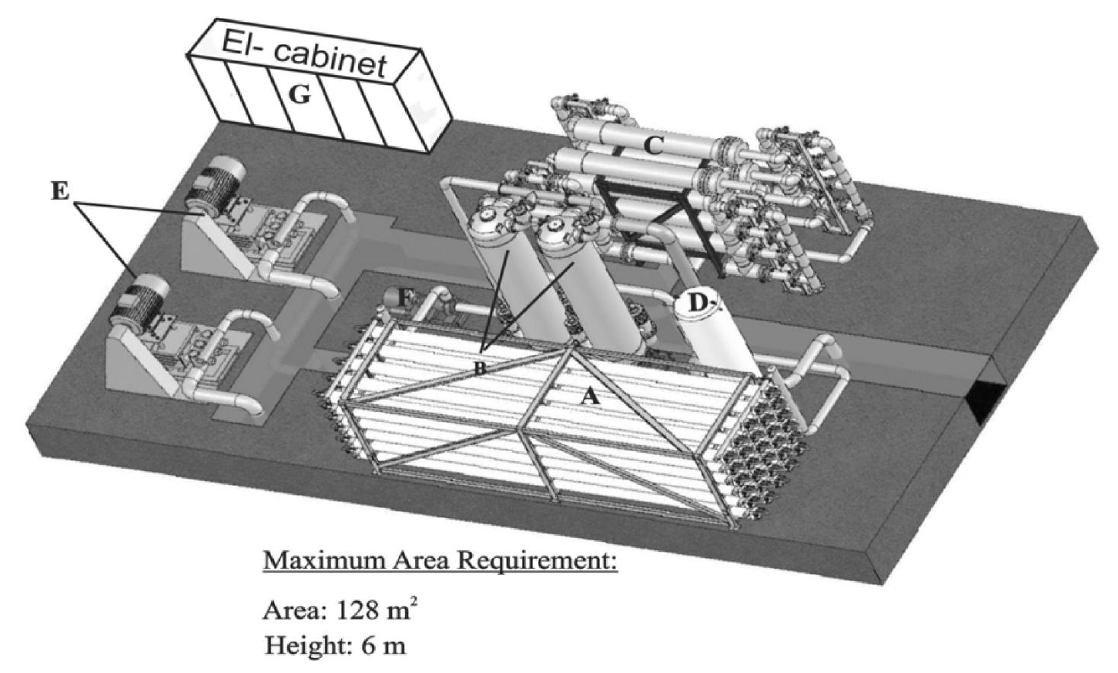
Figure 3. Typical RO stage installation. (A) Pressure vessel, membranes and manifolds; (B) pressure recuperator towers; (C) bag filters; (D) seawater feeding tank; (E) high pressure pumps; (F) booster pump; (G) electro-cabinet (from [1]).